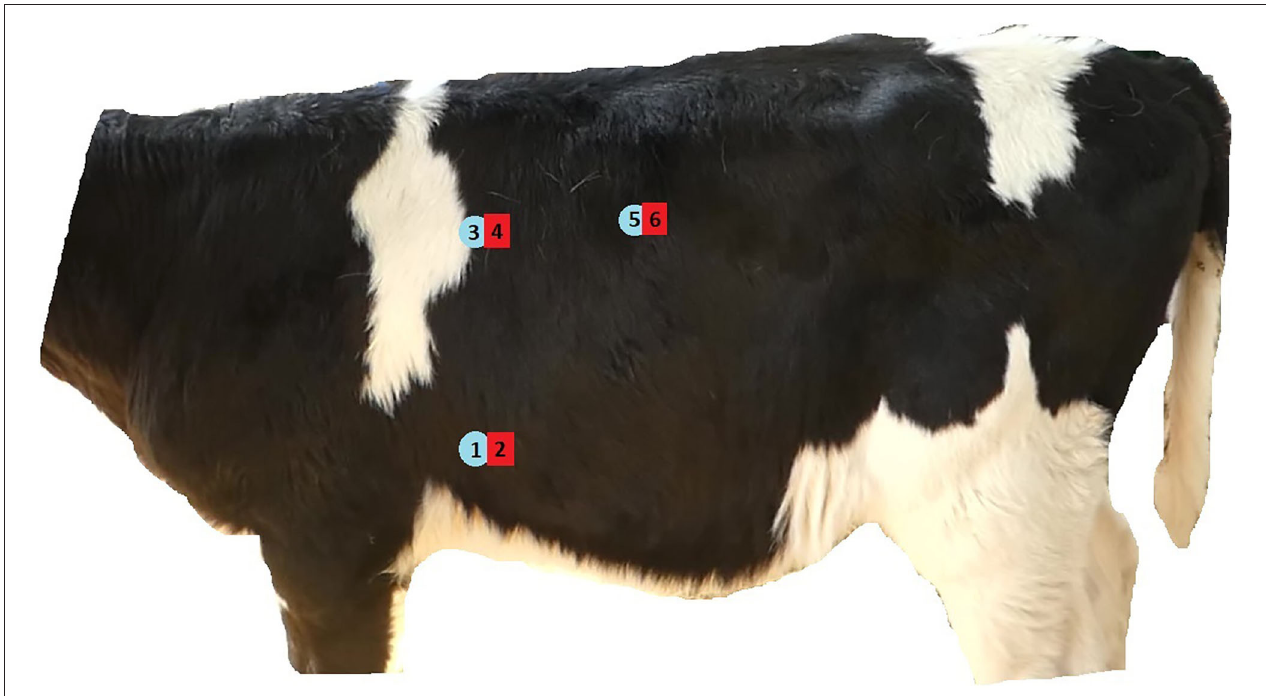
FIGURE 1 | Illustration showing approximate location of six sites used to test repeatability and feasibility of pressure algometry for measuring mechanical nociceptive threshold on calves’ thoraces.